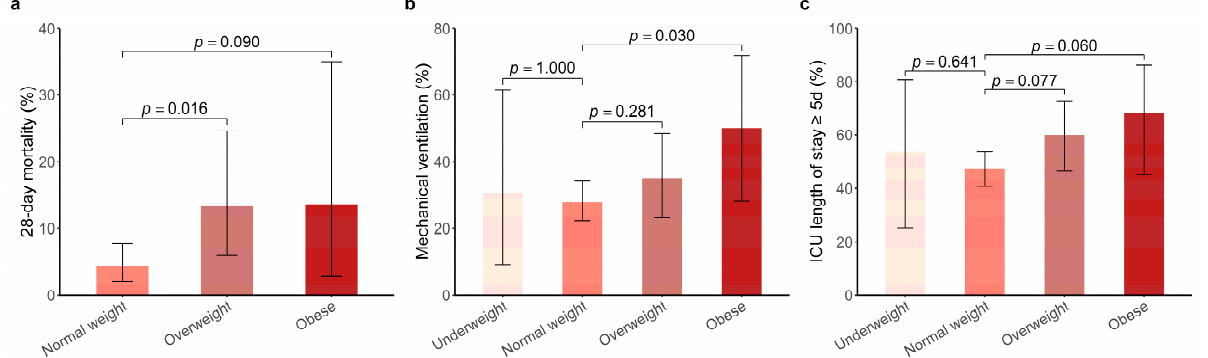
Figure 3. Comparison of clinical severity including 28-day mortality ( a ), mechanical ventilation ( b ) and ICU length of stay ≥ 5 d ( c ) in abdominal trauma patients with different BMI classifications. p values above each bar plot indicate significance between the respective BMI group of abdominal trauma patients (underweight, overweight, and obese) and the normal weight. The error bars denote the confidence interval, which was calculated based on exact binomial distribution. ICU, intensive care unit. Table 2. Associations between different body composition indices and 28-day mortality, mechanical ventilation, and ICU length of stay ≥ 5 d in patients with abdominal trauma.